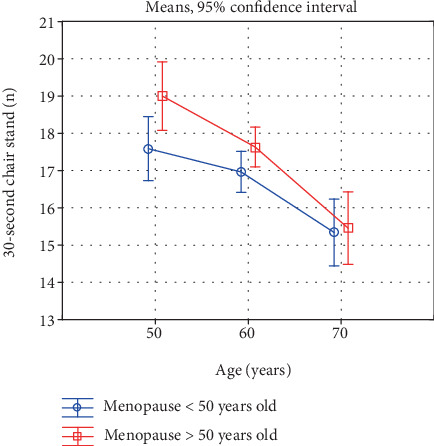
Changes in lower extremities strength with age in early- and late-menopausal women.